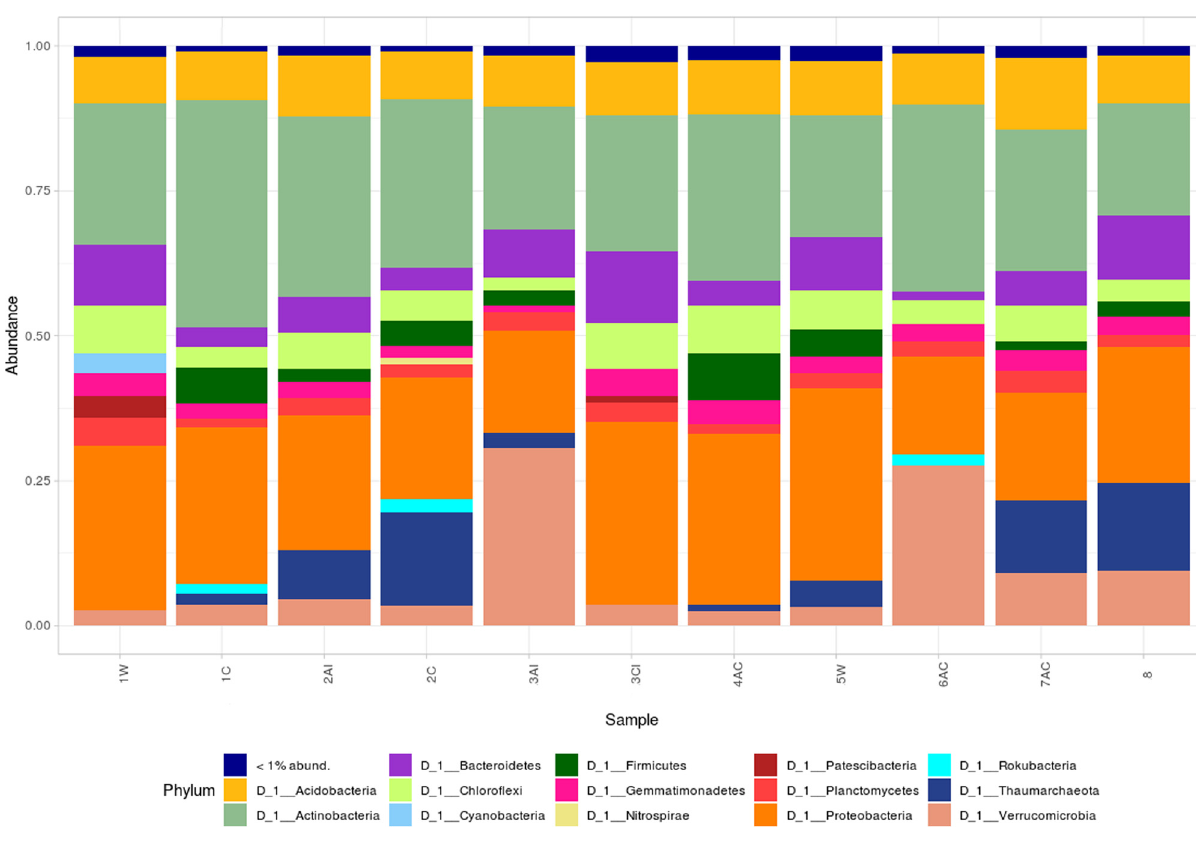
Figure 2: Community taxonomic composition.